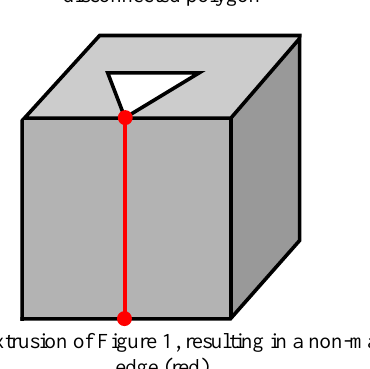
Figure 3: Extrusion of Figure 1, resulting in a non-manifold edge (red)